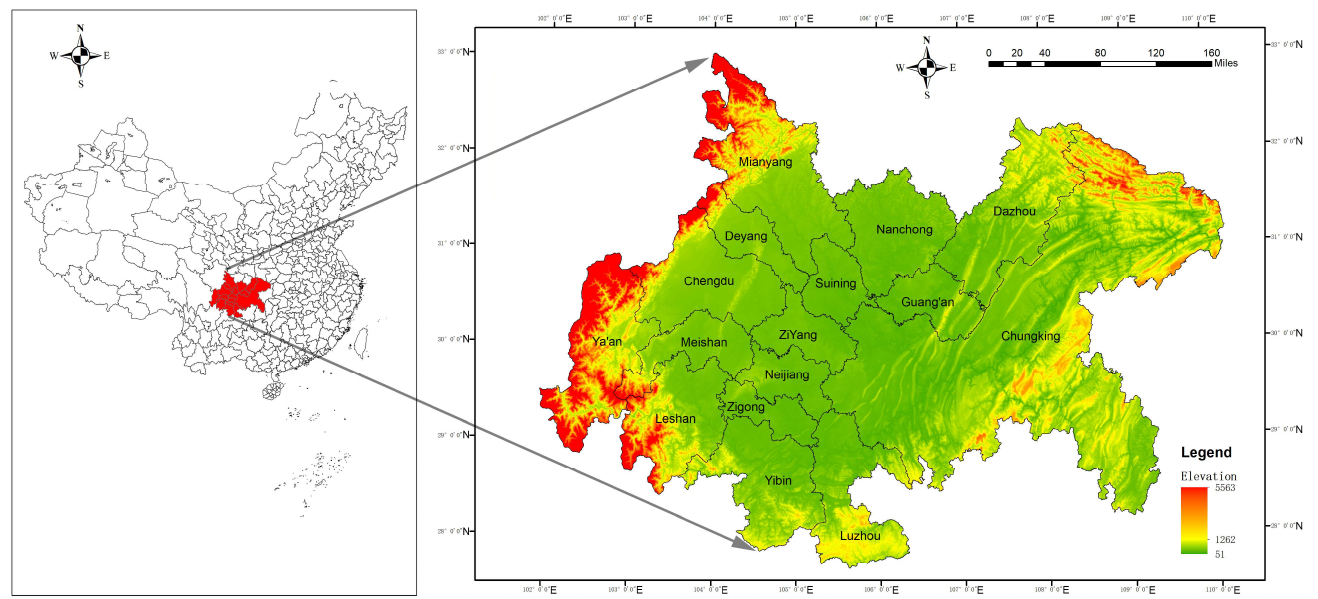
Figure 2. Geographical location of the Chengdu–Chongqing region and composition of the city groups.